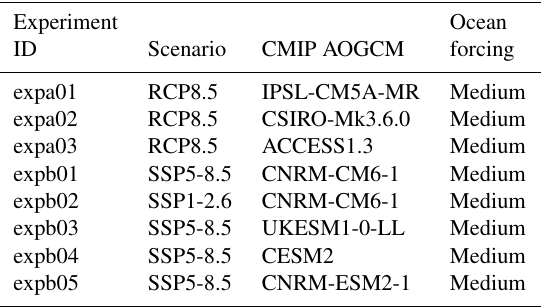
Table A5. Description of ISMIP6 Greenland Tier 2 simulations.